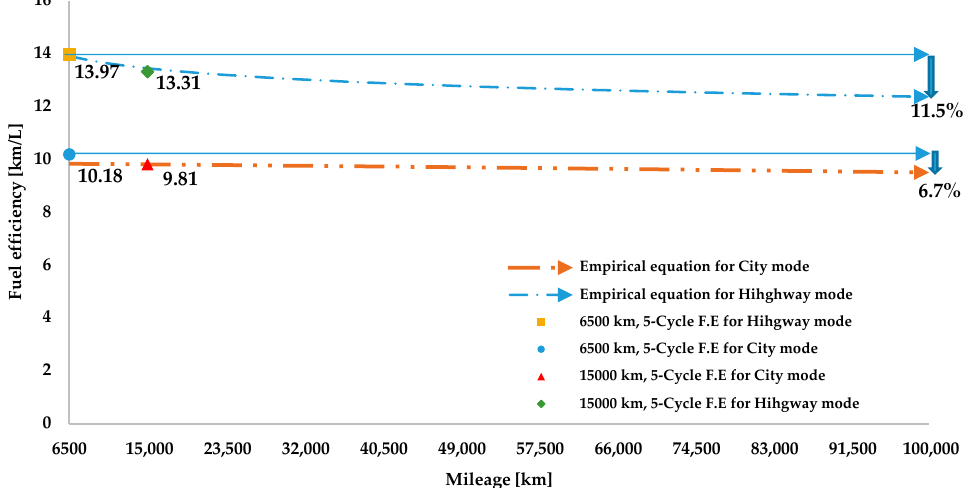
Figure 13. Forecast of fuel consumption for city and highway mode of A vehicle with the cumulative increase in vehicle mileage.